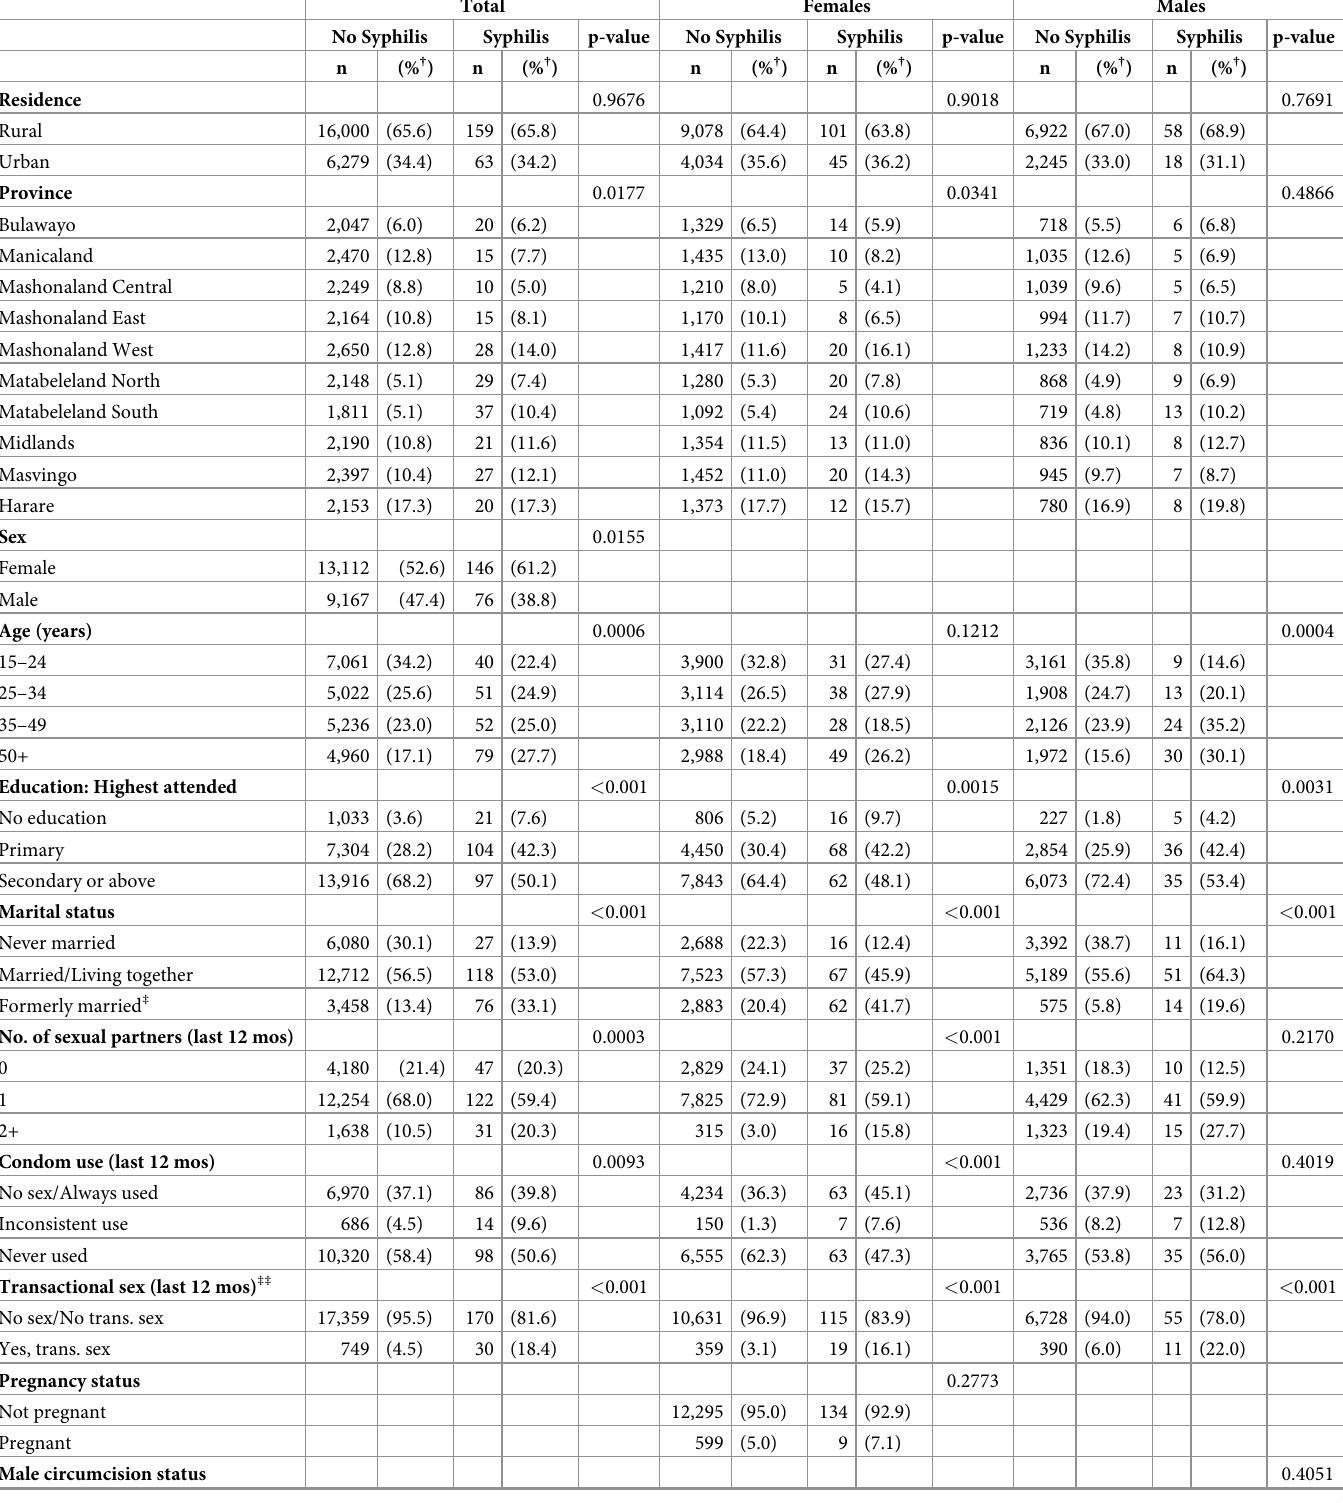
Table 1. Active syphilis and selected characteristics by sex, ages 15+; ZIMPHIA